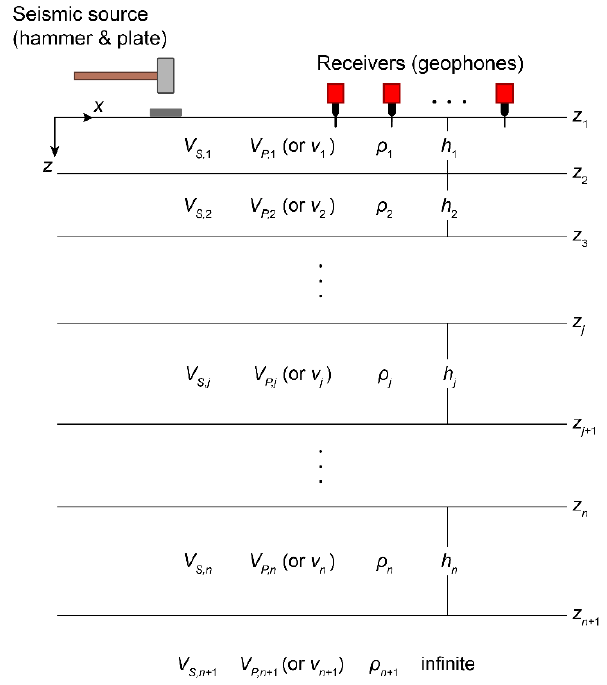
Figure 1. Semi-infinite layered soil model for the inversion analysis.